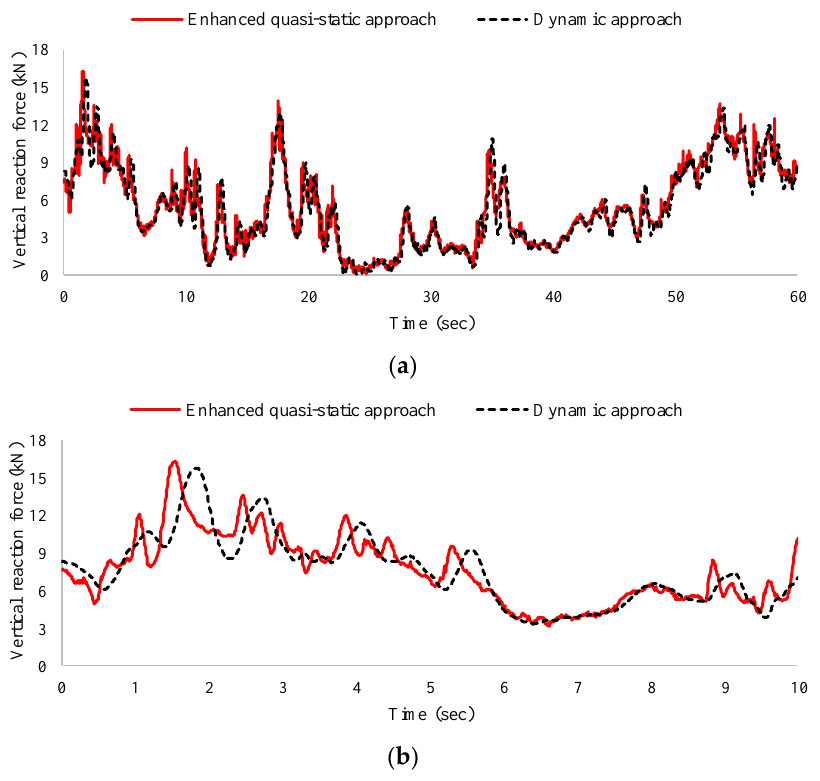
Figure 14. Windward vertical reaction force of the enhanced quasi-static trailer model for ( a ) whole period and ( b ) first 10 s.